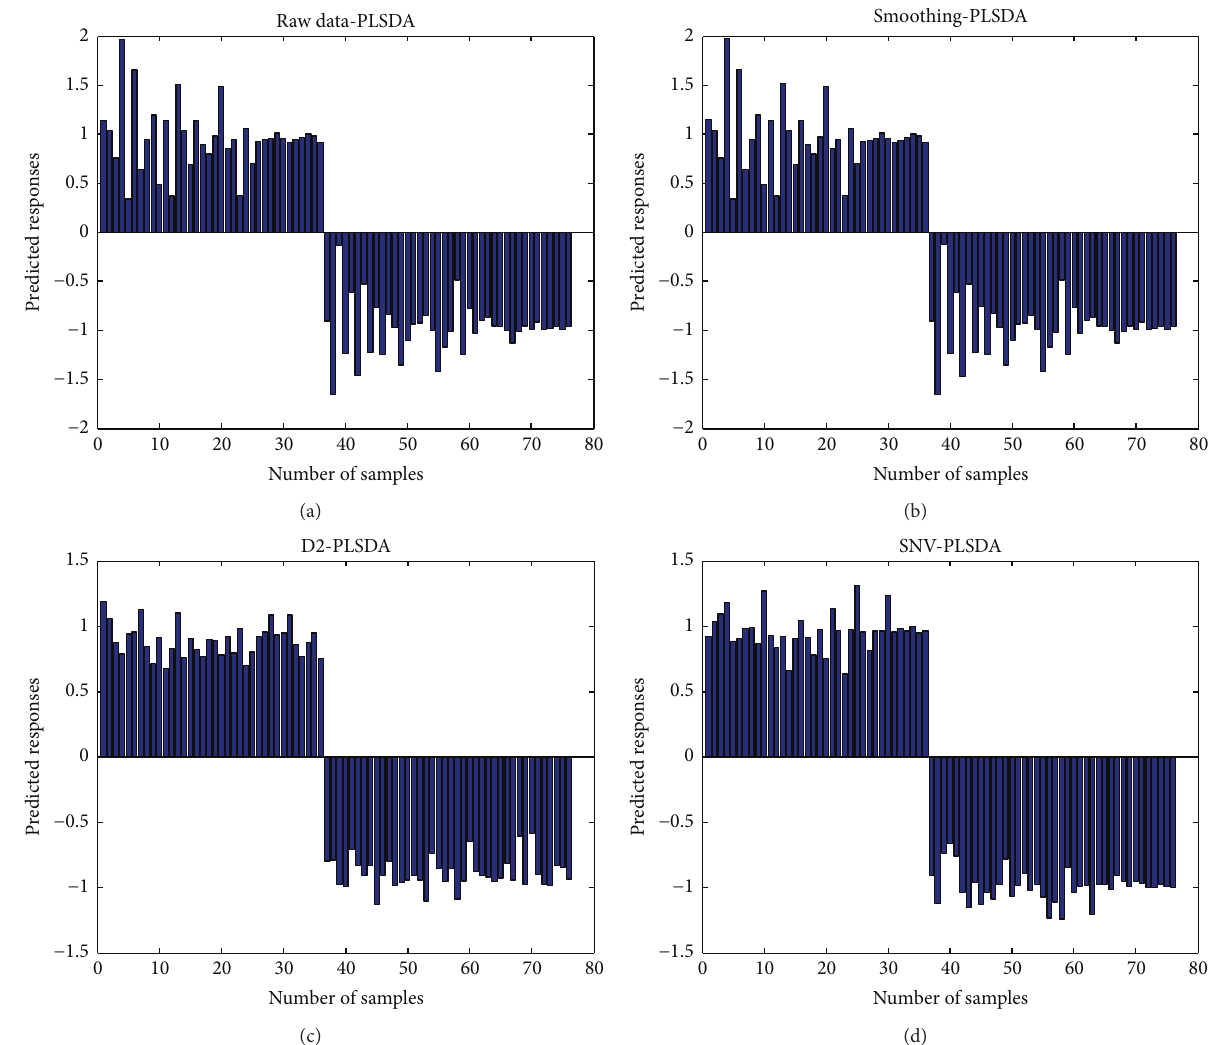
Figure 3: The predicted responses by PLSDA with different data preprocessing; test samples 1–36 are regular MFLW samples (positives) and 37–76 are Hg-contaminated